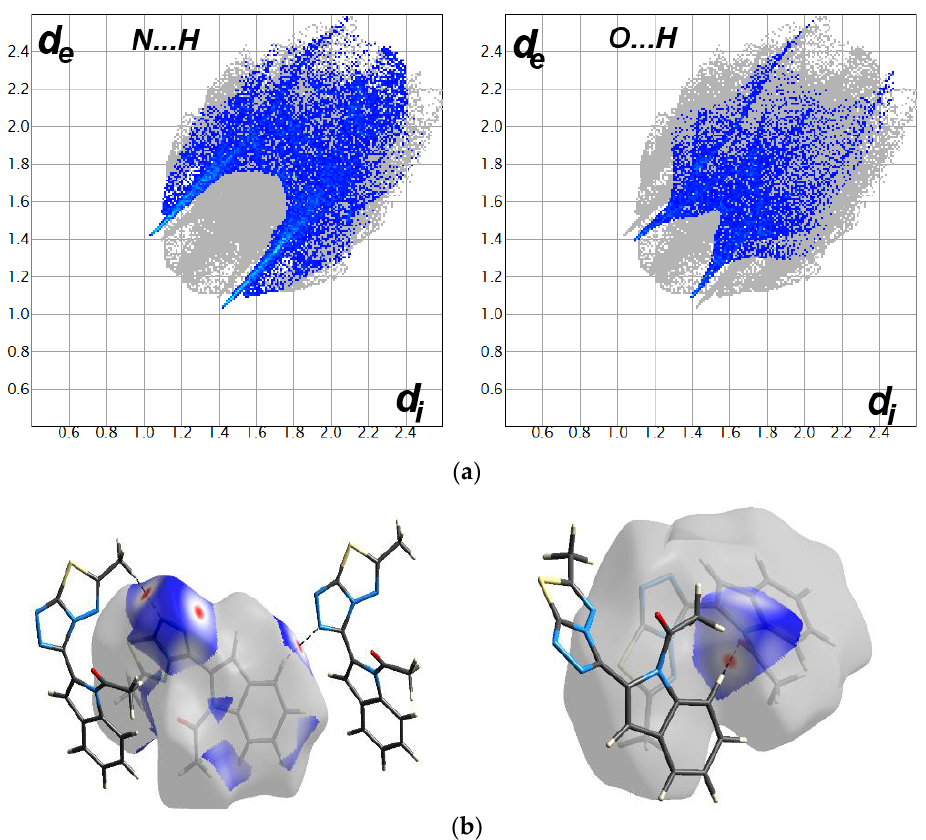
Figure 6. Fingerprint plot ( a ) and d norm surfaces ( b ) of the O···H and N···H contacts. In addition, the shape index map indicated the characteristics of blue/red triangles corresponding to π - π stacking interactions (Figure 7). The shortest non-bonding distances are C3···N4 (3.423(4) Å), C4···C11 (3.565(4) Å), C2···C9 (3.570(3) Å), and C3···C9 (3.579(4) Å), which indicate weak π - π stacks .